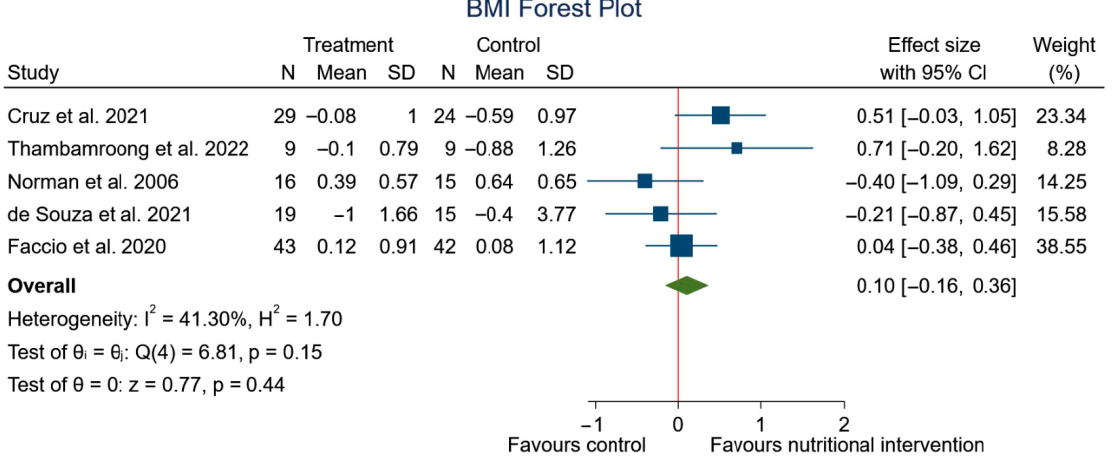
Figure 7. Forest plot summarizing the impact of nutritional intervention on weight using a fixed- effects model. Pooled summary data are presented as standardized mean differences and 95% confidence interval [41,42,52,53,55].